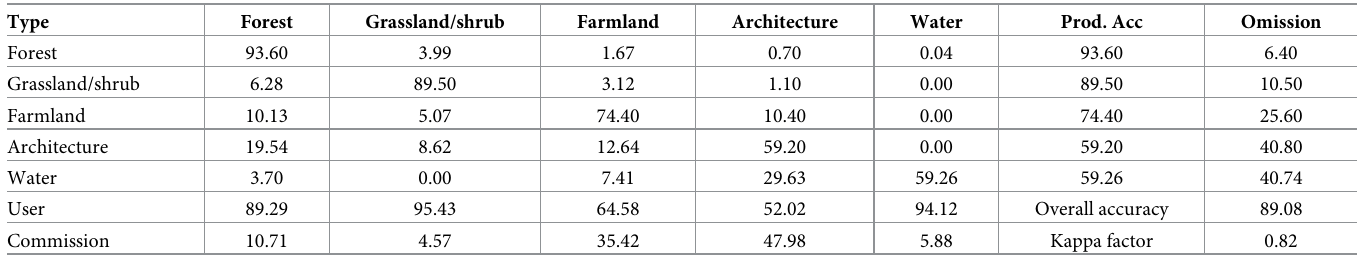
Table 8. Accuracy of object-oriented classification of Yugu Cave.